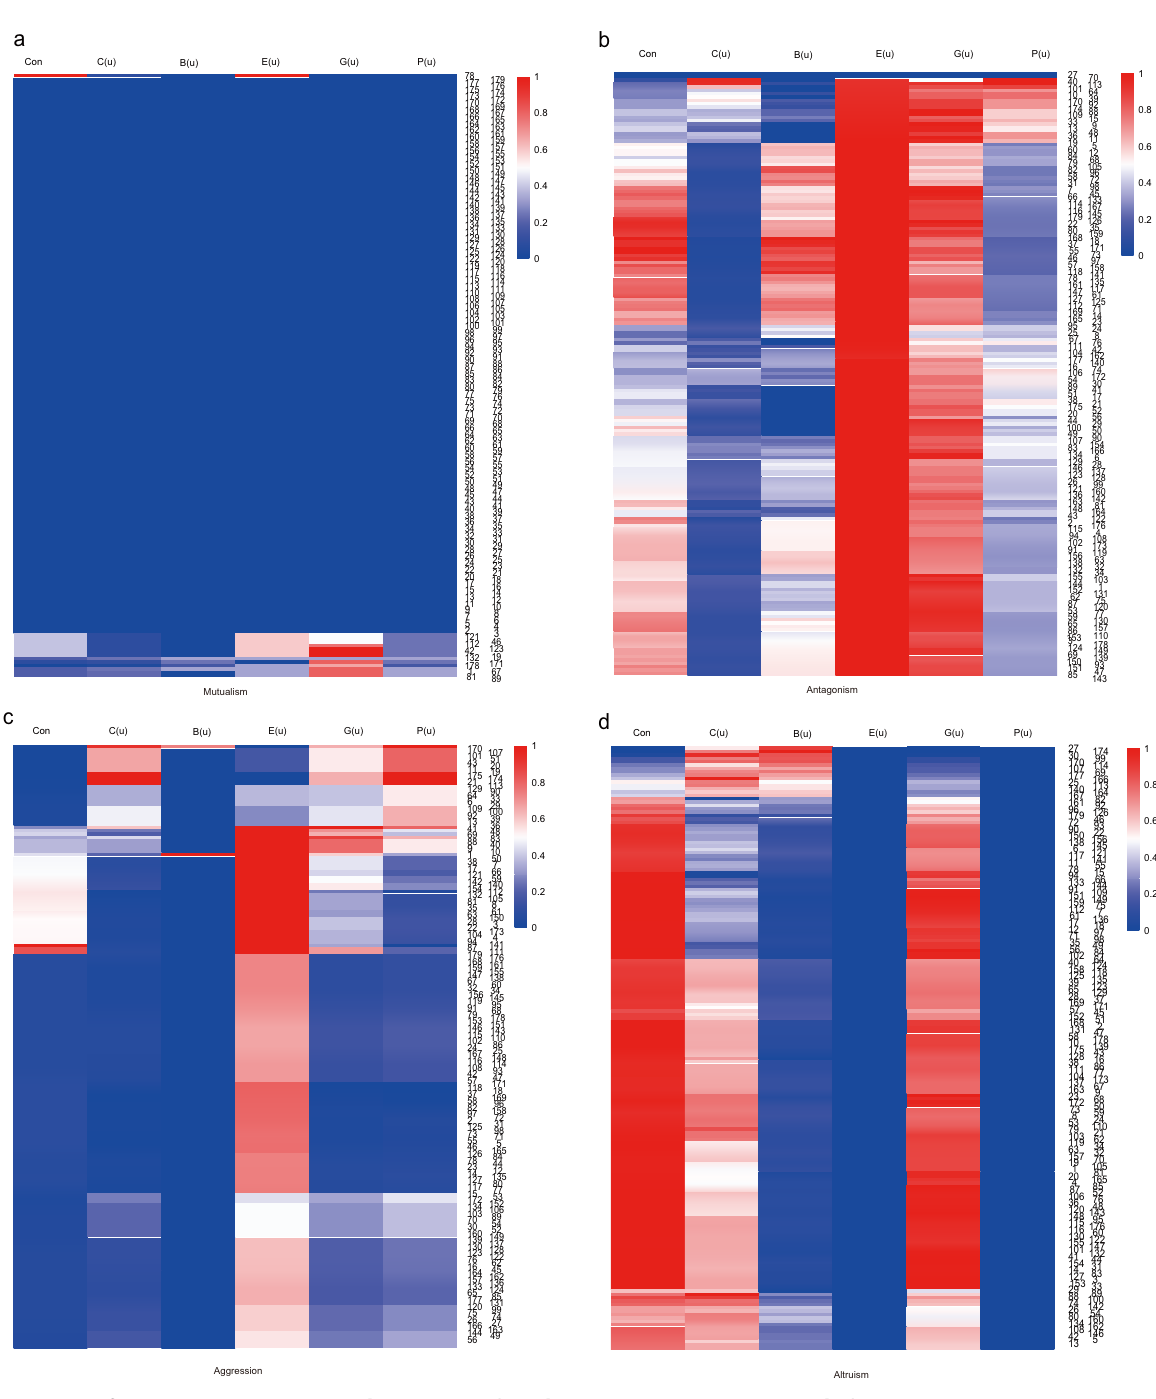
Fig. 3 Heatmap of six emergent property indices. a Mutualism. b Antagonism. c Aggression. d antagonism network, which encodes disease resistance protein (TIR-NBS class). TIR-NBS protein is involved in disease resistance in Arabidopsis 52 . There are 12 pleiotropic genes including UPL4(AT5G02880) , which are detected to in fl uence multiple types of microbial networks or properties (Table 1). UPL4 encodes a ubiquitin-protein ligase, function additively in the regulation of plant growth and development, and positively modulate immune hormone salicylic acid (SA)-mediated basal and induced resistance responses 53 .